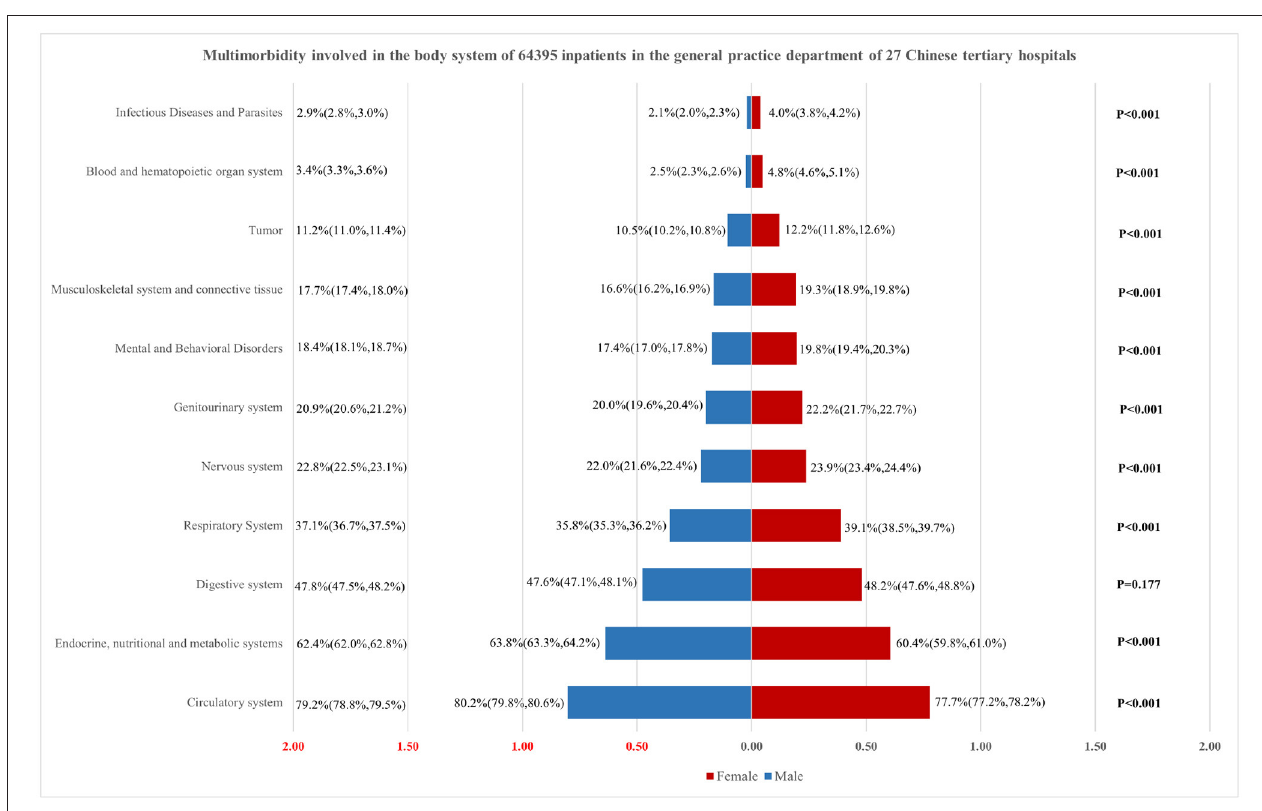
FIGURE 1 | Clinical characteristics of multimorbidity involved in the body